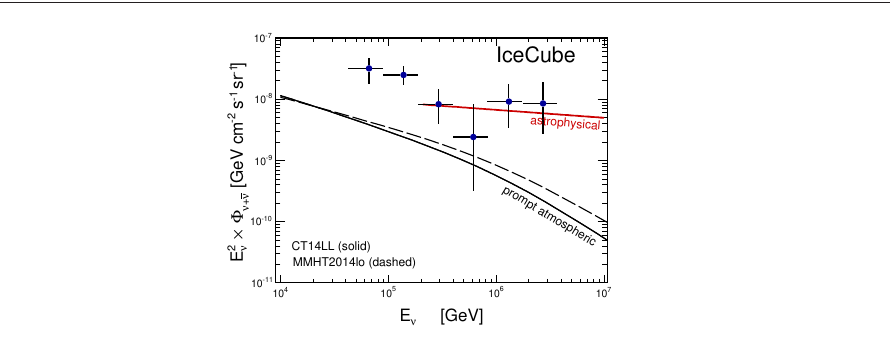
Figure 5. Comparison of predictions obtained with the CT14 and MMHT PDFs for the prompt neutrino flux. The data points are taken from IceCube analysis [11]. For comparison, a fit for the astrophysical contribution, proposed in [11] is presented as well.